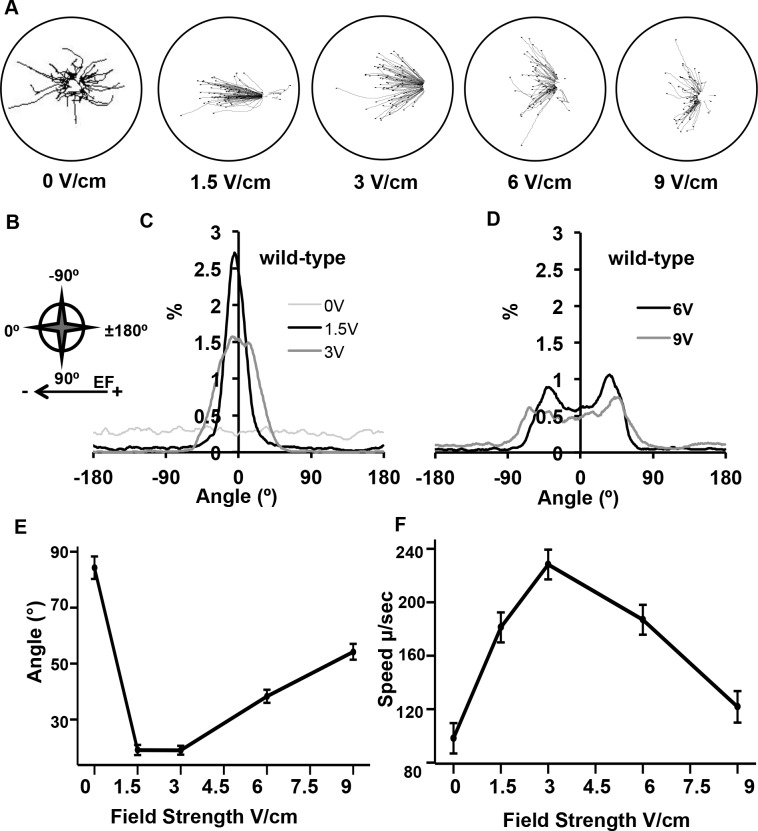
Electrotaxis behavior in wild-type animals at multiple field strengths.(A) Trajectories of individual animals within a population at applied field strengths of 0, 1.5, 3, 6 and 9 V/cm. (B) Orientation of trajectory angles. Angle coordinates were assigned in 1° increments from 0 to ± 180°. Negative and positive angles represent direction above and below X-axis. (C-D) Distribution of trajectory angles for different electric field strengths. Lines are smoothed using a seven point moving average. (E) Mean trajectory angles of wild-type animals are significantly different at all electric field strengths in comparison to non-stimulus at 0 V/cm (p ≤ 0.0001). The trajectory angles above (+) and below the X-axis (-) were combined and plotted as absolute values. (F) Mean speed of wild-type animals increases significantly at electric field strengths of 1.5–9 V/cm relative to non-stimulus speed (p < 0.0001). For (E) and (F), error bars represent SEM; number of individual animal tracks per genotype (N) ≥ 154. P-values were determined from post-hoc pairwise comparisons of estimates obtained via general linear mixed-models. Significance was assessed using a false discovery rate of 0.05.